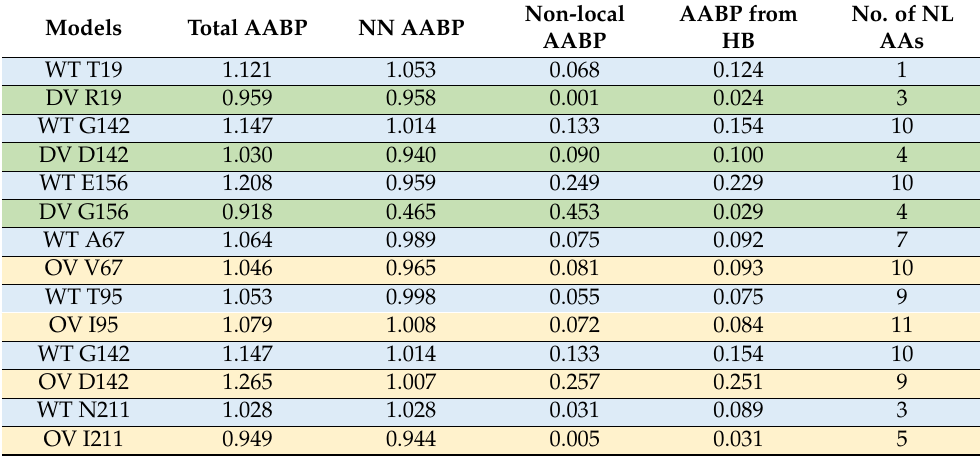
Table 1. Comparison of AABP units of NTD sites between wild type (WT), Delta variant (DV), and Omicron variant